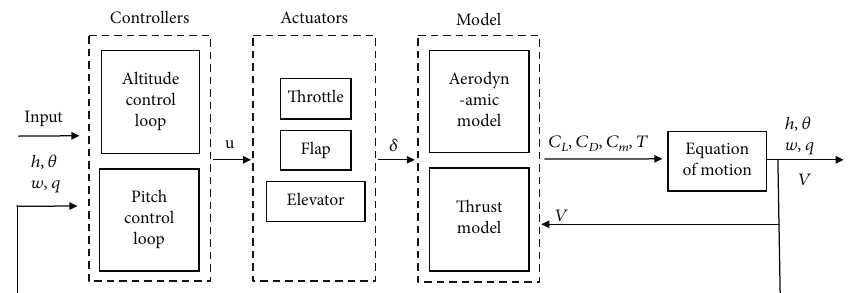
Figure 2: Structure of control model.